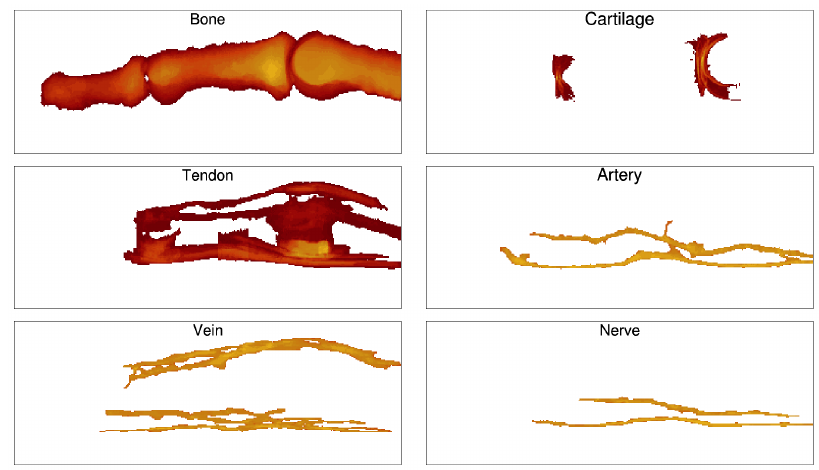
Figure 9. Sagittal projections showing total thickness of different tissues in the index finger model.